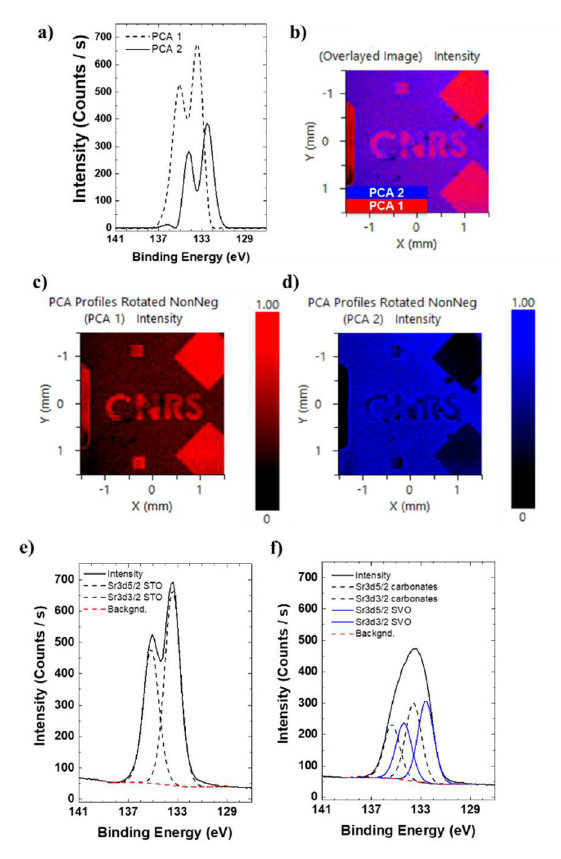
Fig. . Sr3d image treatment using PCA mathematical process: (a) eigenvectors considered (PCA 1 and PCA 2), (b) overlayed PCA profiles (c) PCA 1 profile, (d) PCA 2 profile, Sr3d spectrum obtained by regular XPS in STO patterns (e) and free SVO